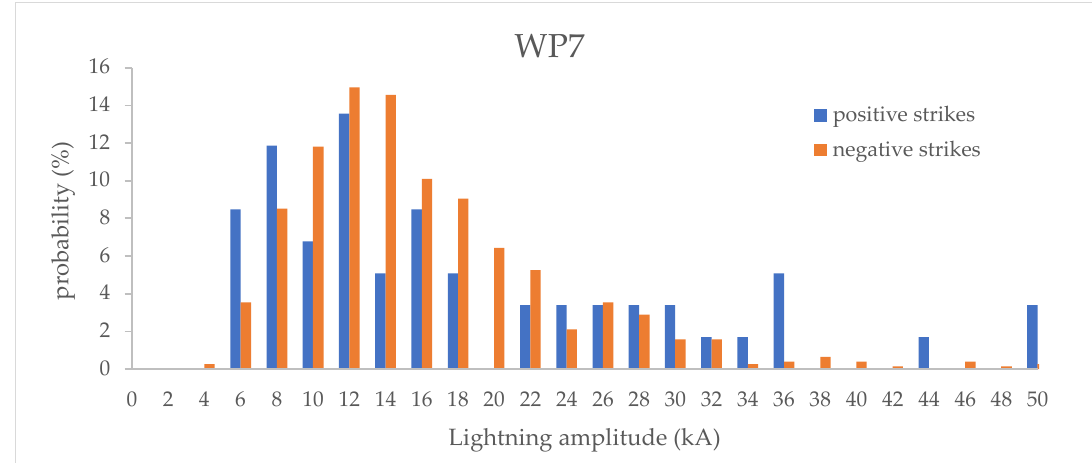
Figure A6. Lightning current amplitude probability distributions for positive and negative strikes extracted from the rec- orded incidents throughout the period 2011–2020 for WP6.